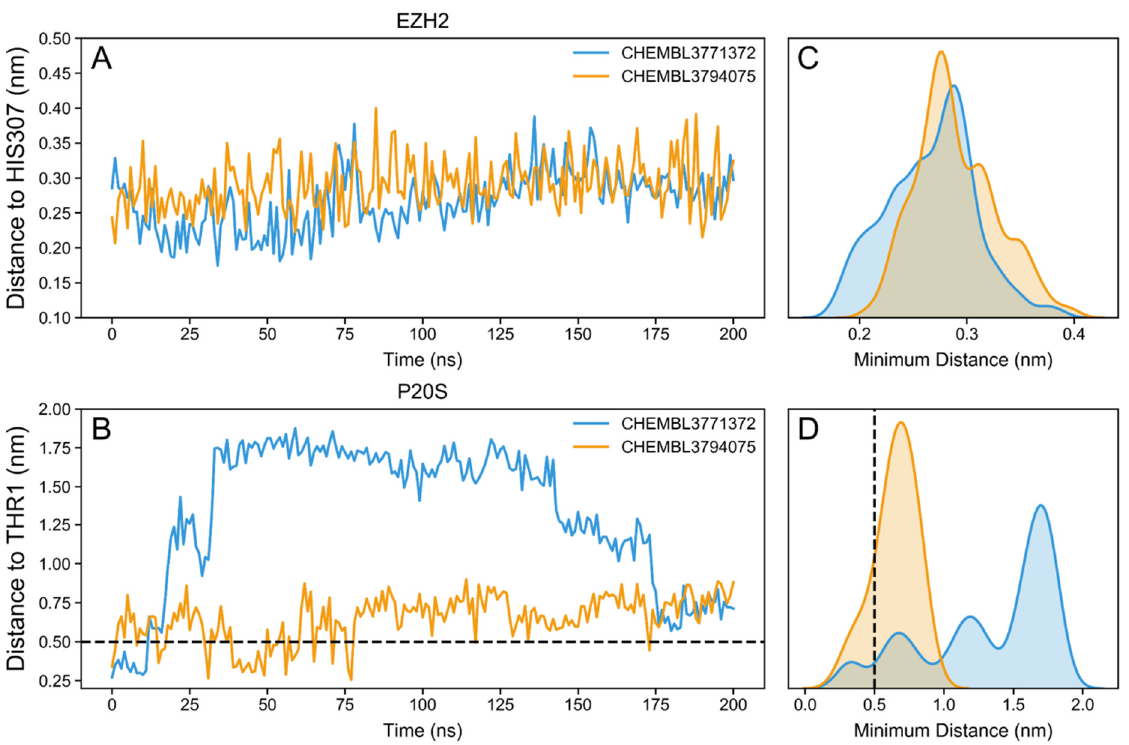
Figure 16. Distance from both docking hits to EZH2’s HIS307 ( A ) and to P20S’s THR1 ( B ). Distribution of minimum distances to HIS307 ( C ) and THR1 ( D ) recorded throughout the full 200 ns simulation.